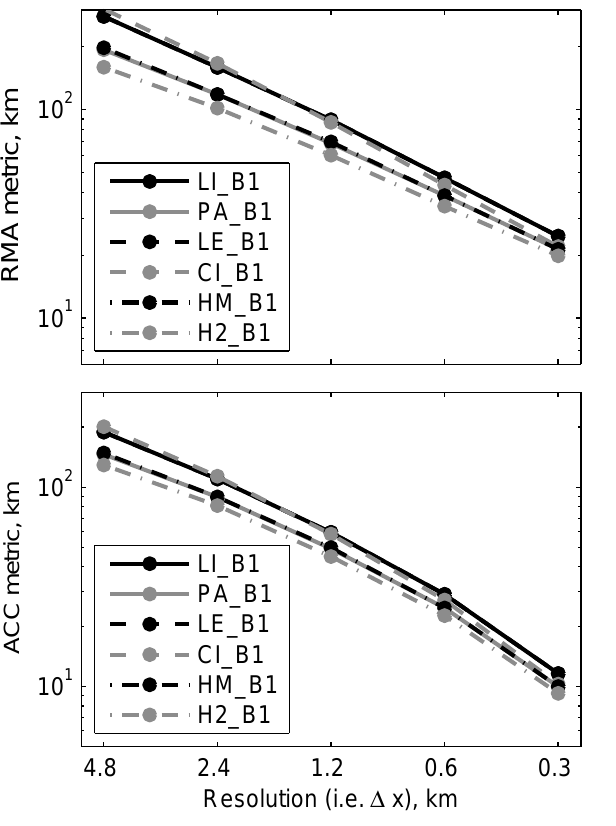
Fig. 10. Error metrics ACC and RMA (Sect. 4.1) plotted against resolution for the GLPs using the simplest forcing term correc- tion, B1 (Sect. 3.2.2). Results are shown for all thickness profiles (Sect. 3.1).